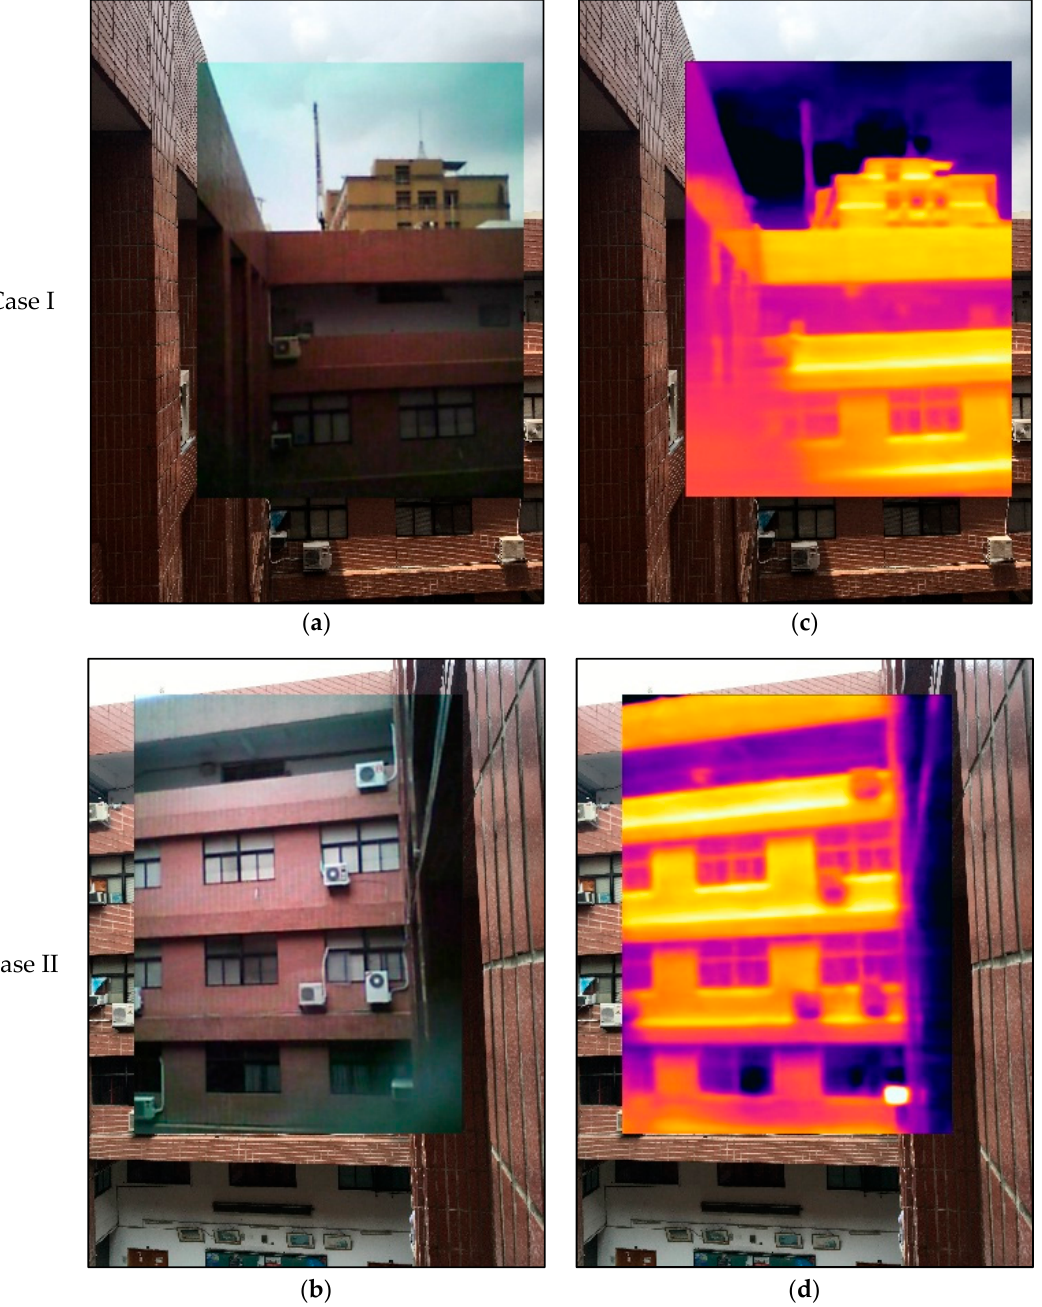
Figure 6. Image registration of exterior wall of departmental building: ( a , b ) Visible image of FLIR ONE registered for that of iPhone SE; ( c , d ) Thermal IR image of FLIR ONE registered for visible image of iPhone SE. Table 4. NCC indices and computational time of image registration.